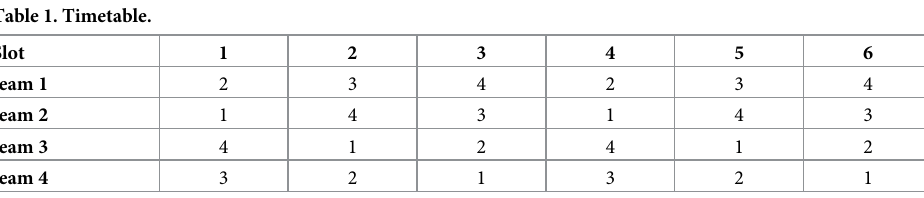
Table 1. Timetable.